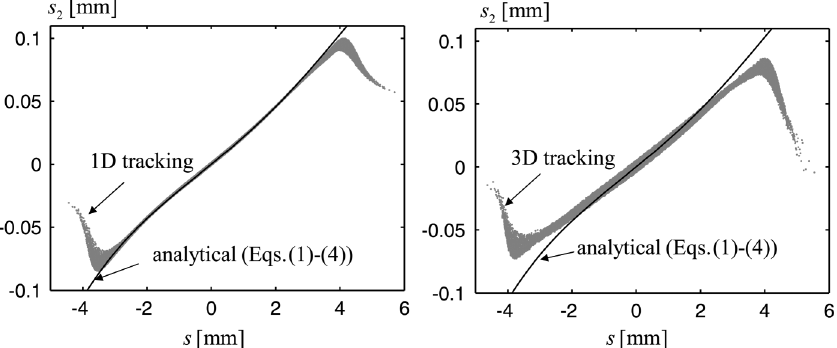
FIG. 9. The rf tolerance in accelerating module M pression in the first BC.